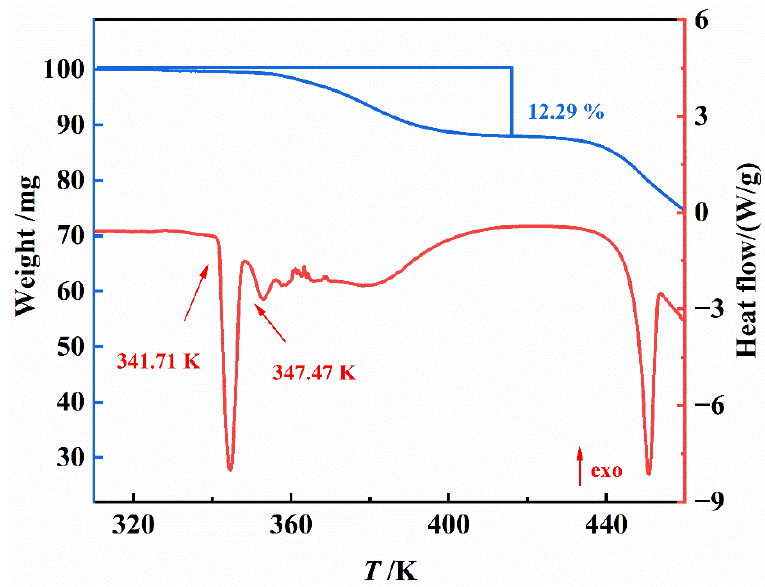
Figure 4. Thermal analysis (TG-DSC) of 1,5-pentanediamine adipate dihydrate.